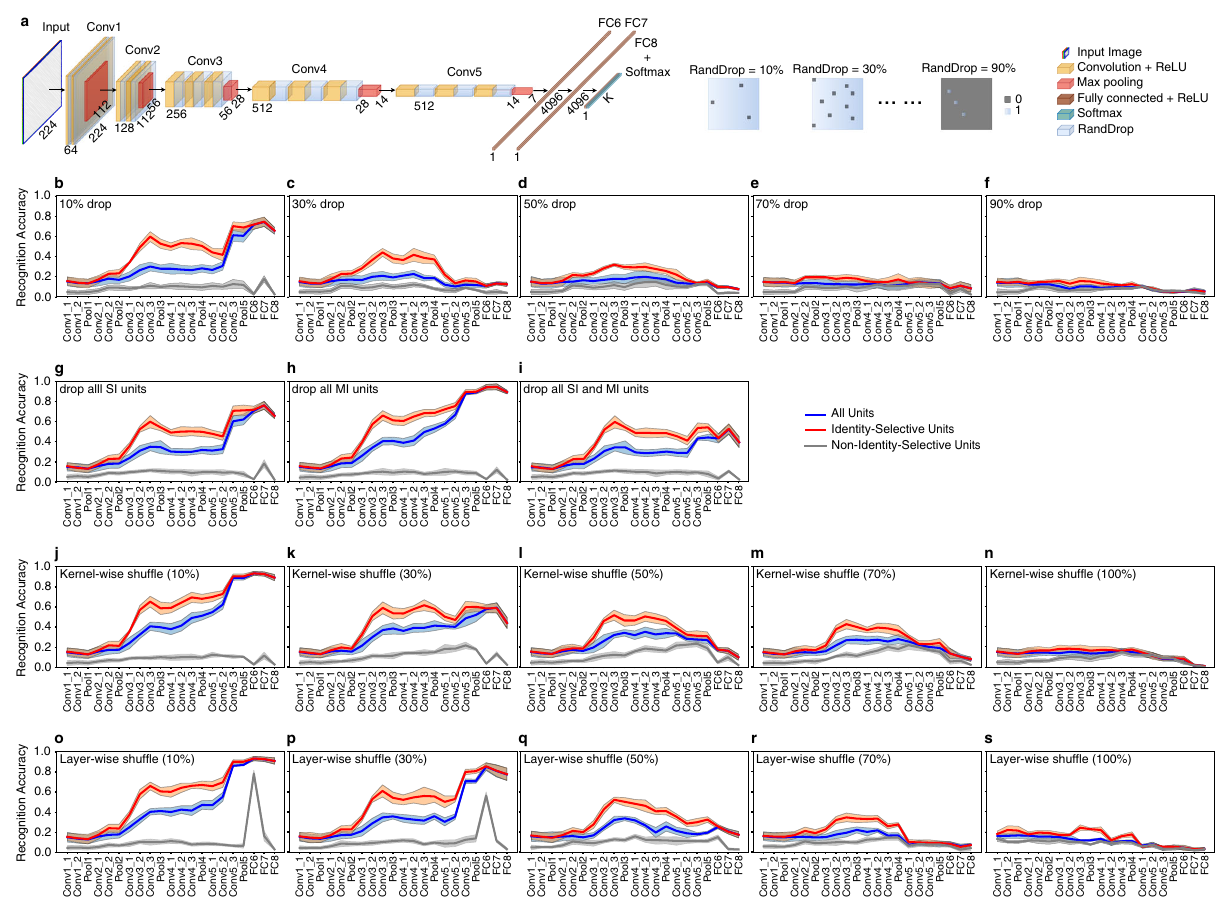
Fig. 4 Manipulation of the deep neural network (DNN). a Illustration of how random dropout of DNN units was performed. We added a binary mask following every convolutional layer in the original DNN architecture to randomly deactivate a subset of DNN units. The percentage of dropped DNN units was controlled by the percentage of zeros in the binary mask and varied from 10 to 90%. b – f Recognition accuracy following a random dropout of DNN units. g – i Recognition accuracy following a complete dropout of ( g ) SI units, ( h ) MI units, and ( i ) combined SI and MI units. j – n Recognition accuracy following kernel-wise shuf fl e. o – s Recognition accuracy following layer-wise shuf fl e. Legend conventions as in Fig.